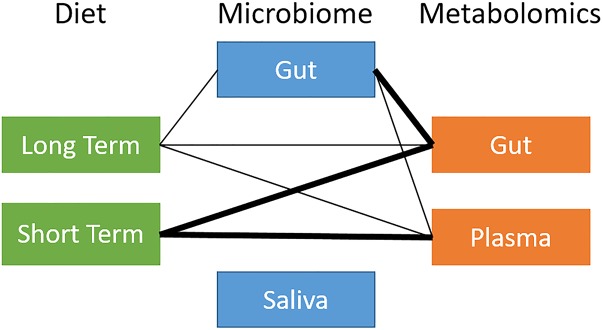
Overview of global relationships between microbiota, diet, and metabolites. Thick line: distance correlation t-test p-value < 10−5; thin line: distance correlation t-test 10−5
< p-value < 10−1.